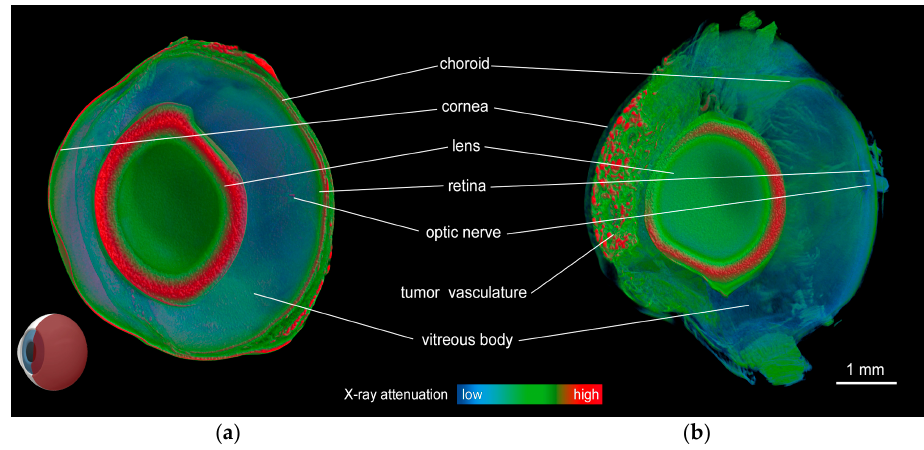
Figure 2. Micro-CT imaging. Volume-rendered 3D image of the hamster eyeball without melanoma ( a ); and with a medium-sized melanoma growing in the anterior chamber stained in Lugol solution for 96 h ( b ). The models are virtually cut in the sagittal plane, as shown in the model eyeball in the lower left corner. Pathological vascularization and tumor masses are clearly visible.